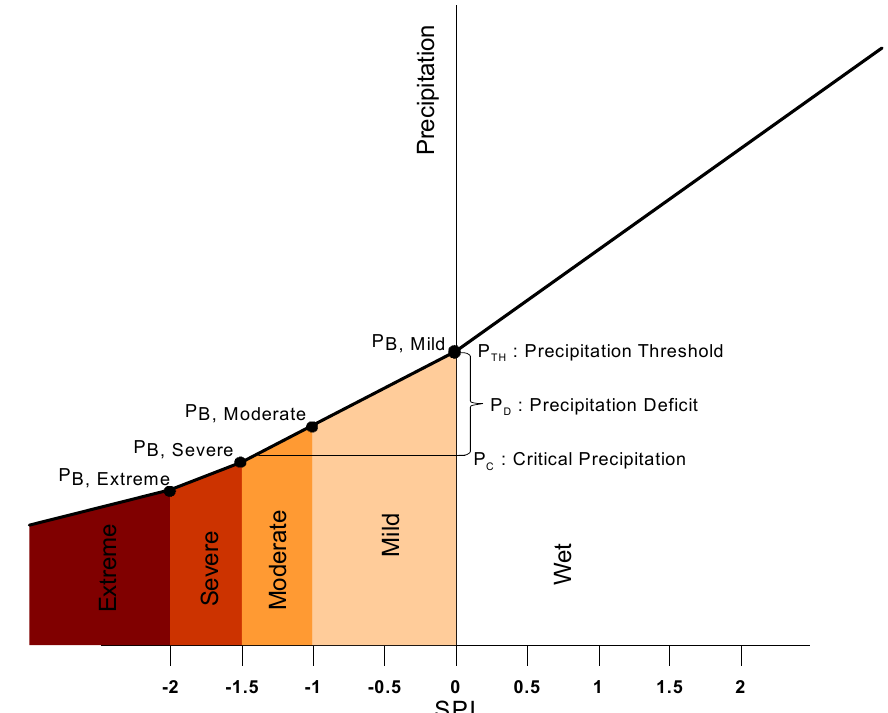
Figure 7. Step-by-step calculation of the precipitation deficit.